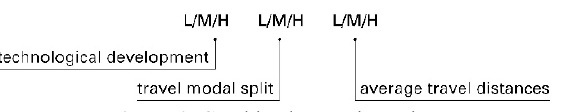
Figure 3. Combined scenario setting